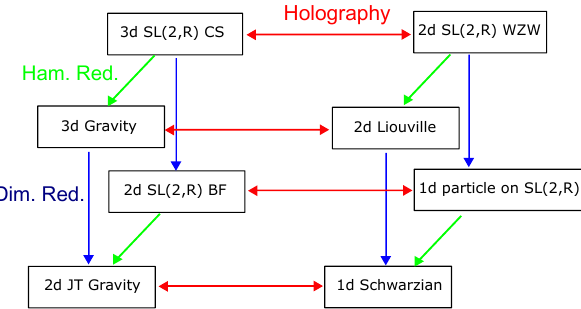
Figure 8 . Relation through holography, the Schwarzian limit (dimensional reduction), and Hamil- tonian reduction of eight